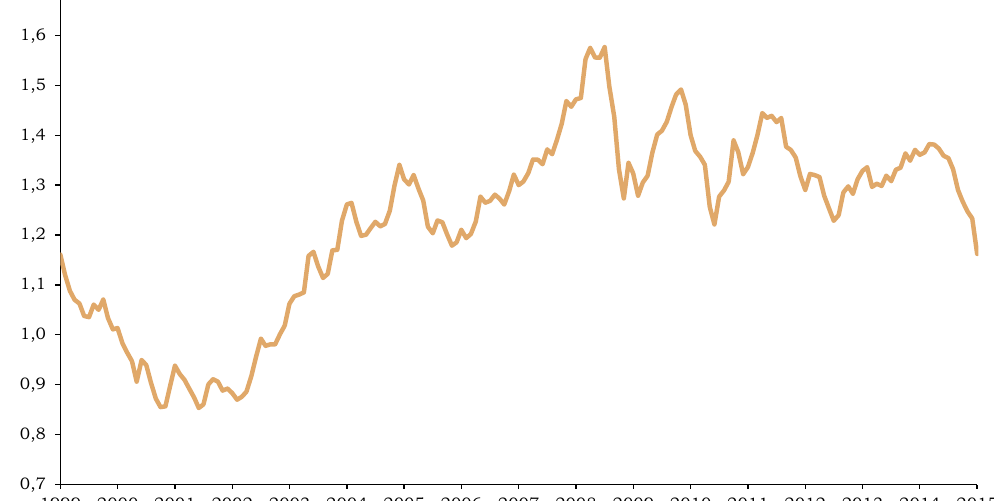
Figure 1 : Nominal exchange rate euro/US dollar,